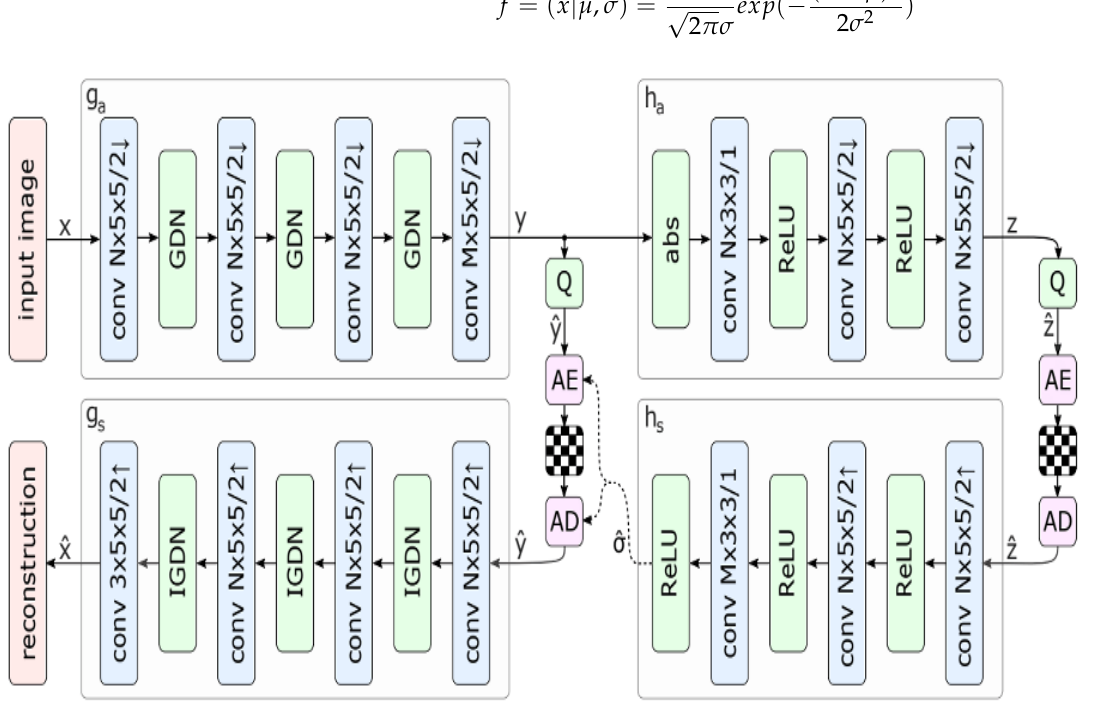
Figure 1. Schematic diagram of the image compression network structure based on super-priori architecture